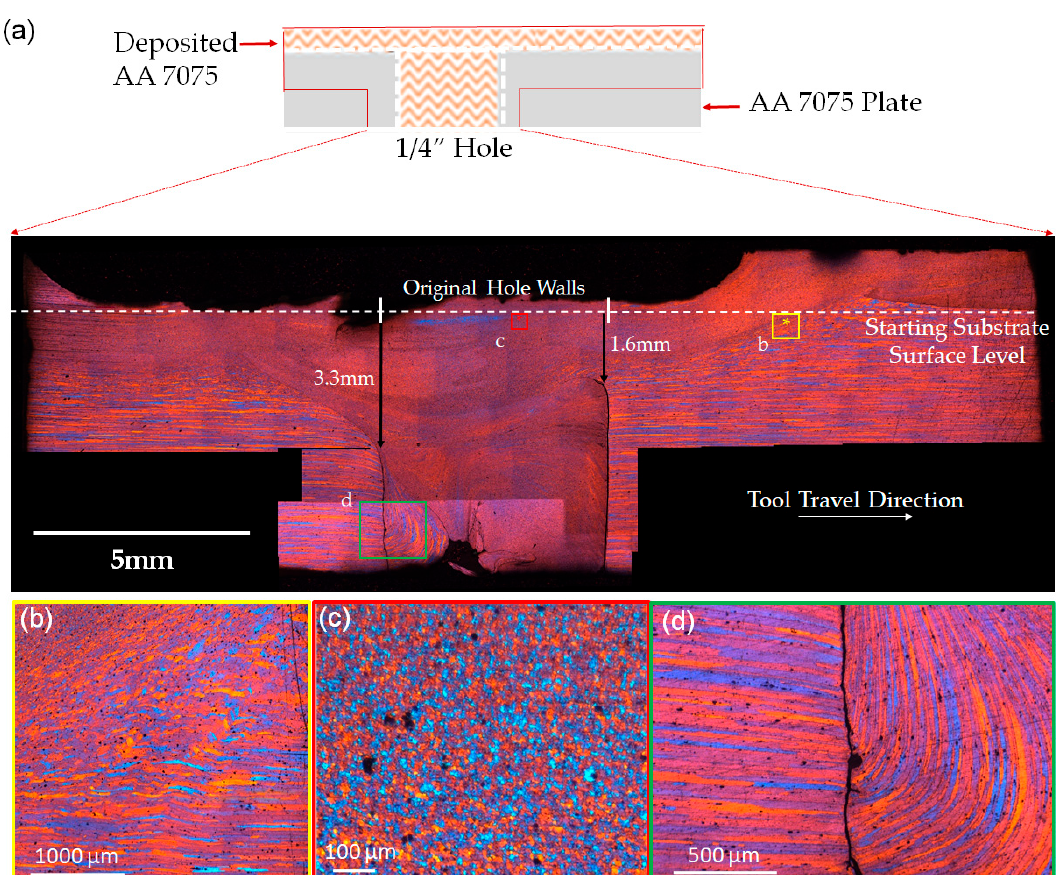
Figure 6. ( a ) Full cross-section of the single hole filling sample created by stitching together multiple optical micrographs. Highlighted regions show ( b ) the transition zone between the substrate plate and the deposited material, ( c ) the typical microstructure in the deposited material, and ( d ) a higher magnification view of the elongated grain region at the bottom of the repaired hole.